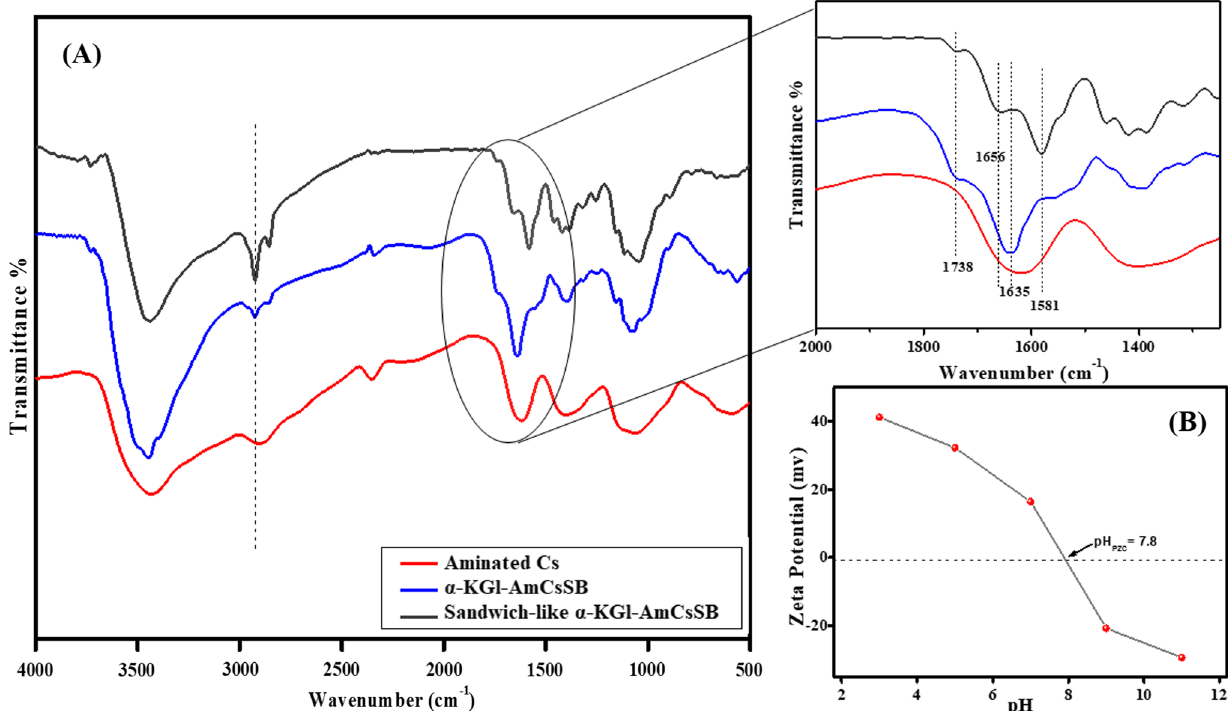
Fig. 1 A FTIR of AmCs, α -kGl-AmCsSB (first step), and sandwich-like α -kGl-AmCsSB, and B ZP of α